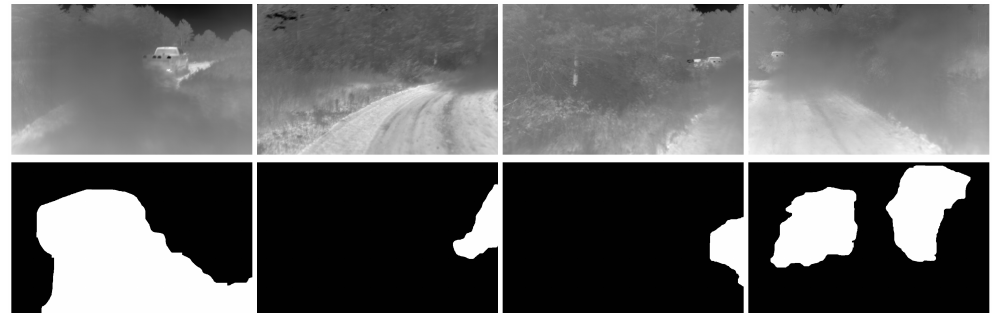
Figure 3. Sample images from our dataset ( top row ) along with corresponding occlusion segmenta- tion ground truth ( bottom row